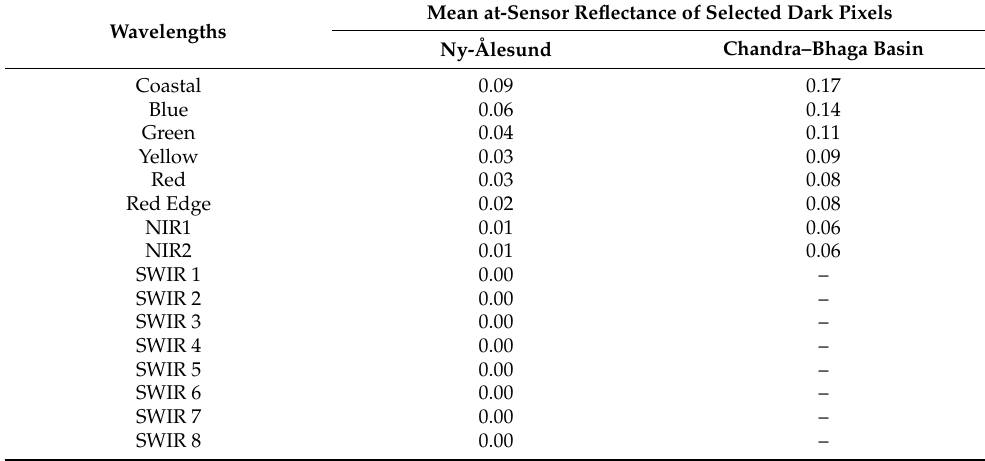
Table 3. TOA reflectance values of selected dark pixels for input into DOS